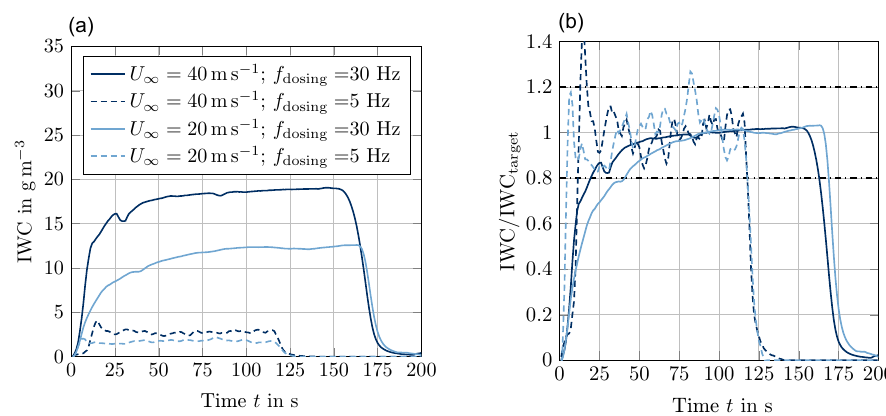
Figure 23. IWC time history based on IKP measurements: (a) IWC history and (b) normalized IWC history.